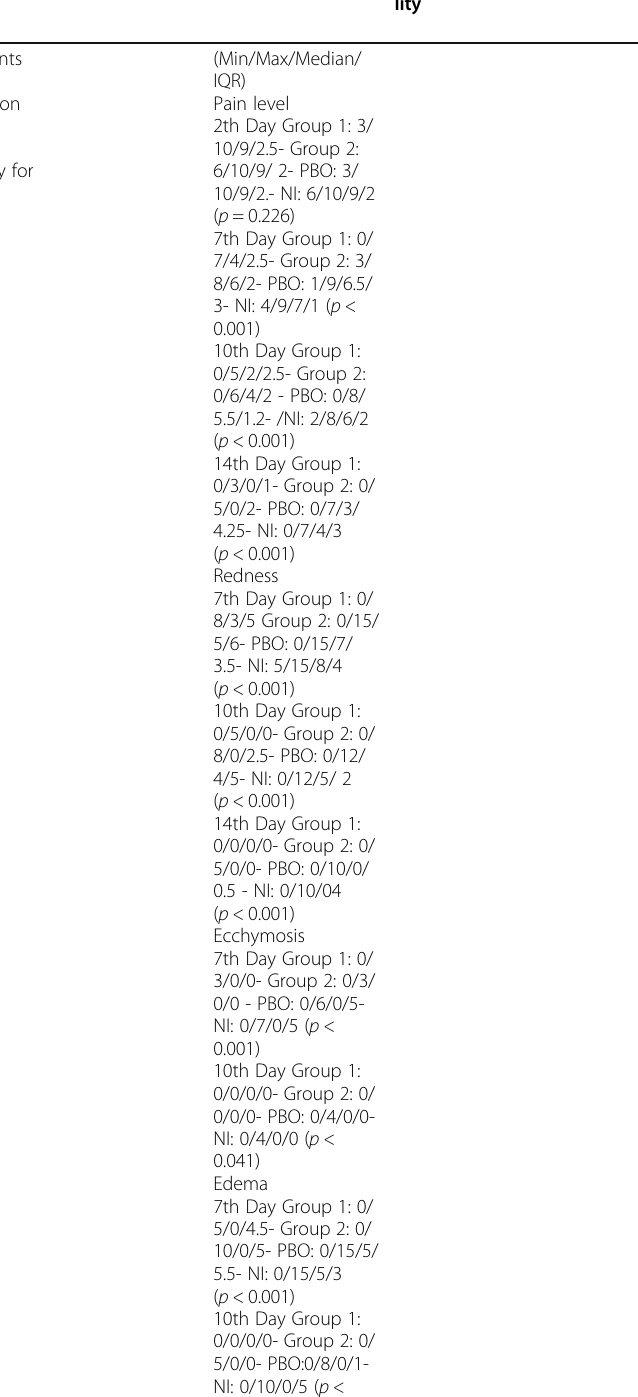
Table 4 Clinical trials of the traditional plants used for skin problems in Turkey (Continued) Study Patient